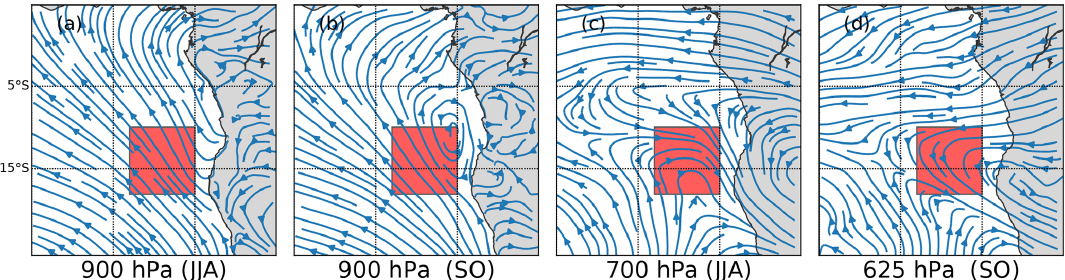
Figure A1. Streamlines corresponding to the average horizontal wind speed at 900hPa (representative of cloud level) in JJA and SO and 700 (625)hPa (representative of aerosol layer level) in JJA (SO) for the Pristine* cases (i.e., profiles observed during days when no aerosol above cloud was detected along the satellite track within the whole area of study (red square).